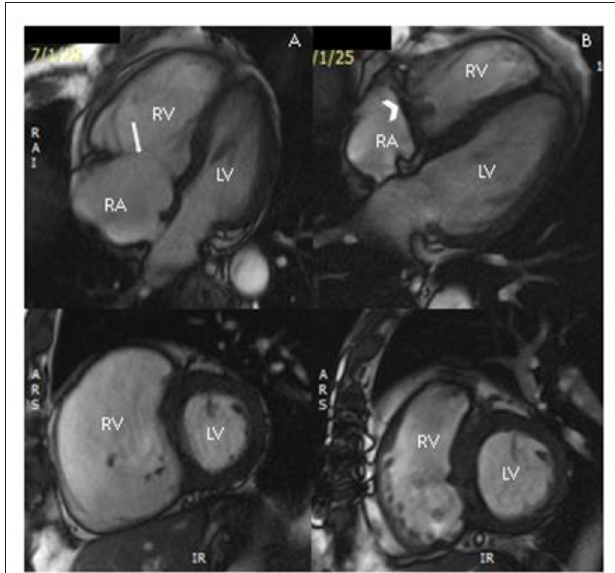
FIGURE 2 | Cardiac magnetic resonance images before surgery (A) demonstrating severe right ventricular dilatation and flattening of the inter-ventricular septum, and post-tricuspid valve replacement (B) demonstrating significant reduction in right ventricular volume; top panel: still from four-chamber cine sequence; lower panel: still from short-axis cine stack at mid-ventricular level. RV, right ventricle; LV, left ventricle; RA, right atrium; arrow, native tricuspid valve; chevron, tricuspid valve